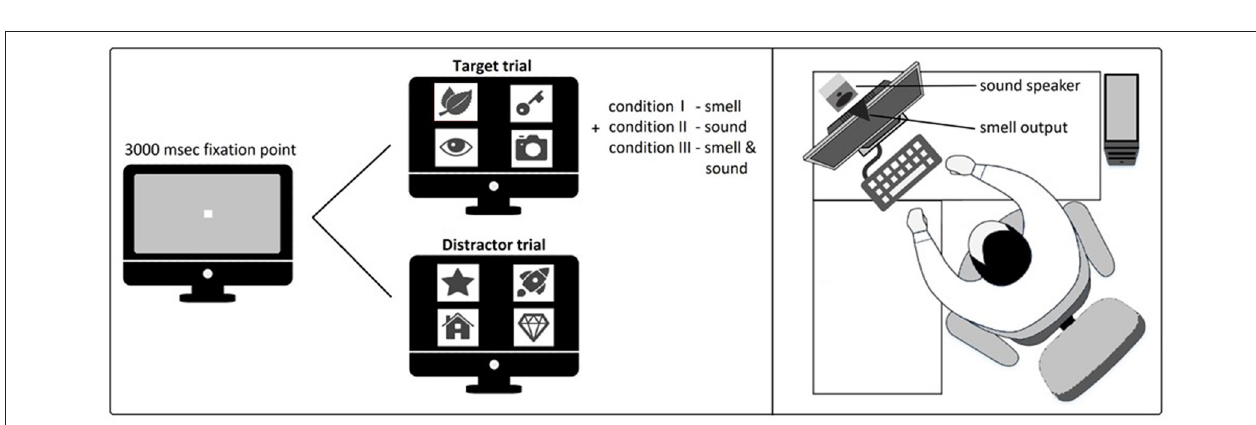
FIGURE 4 | Overview of the secondary task presentation and